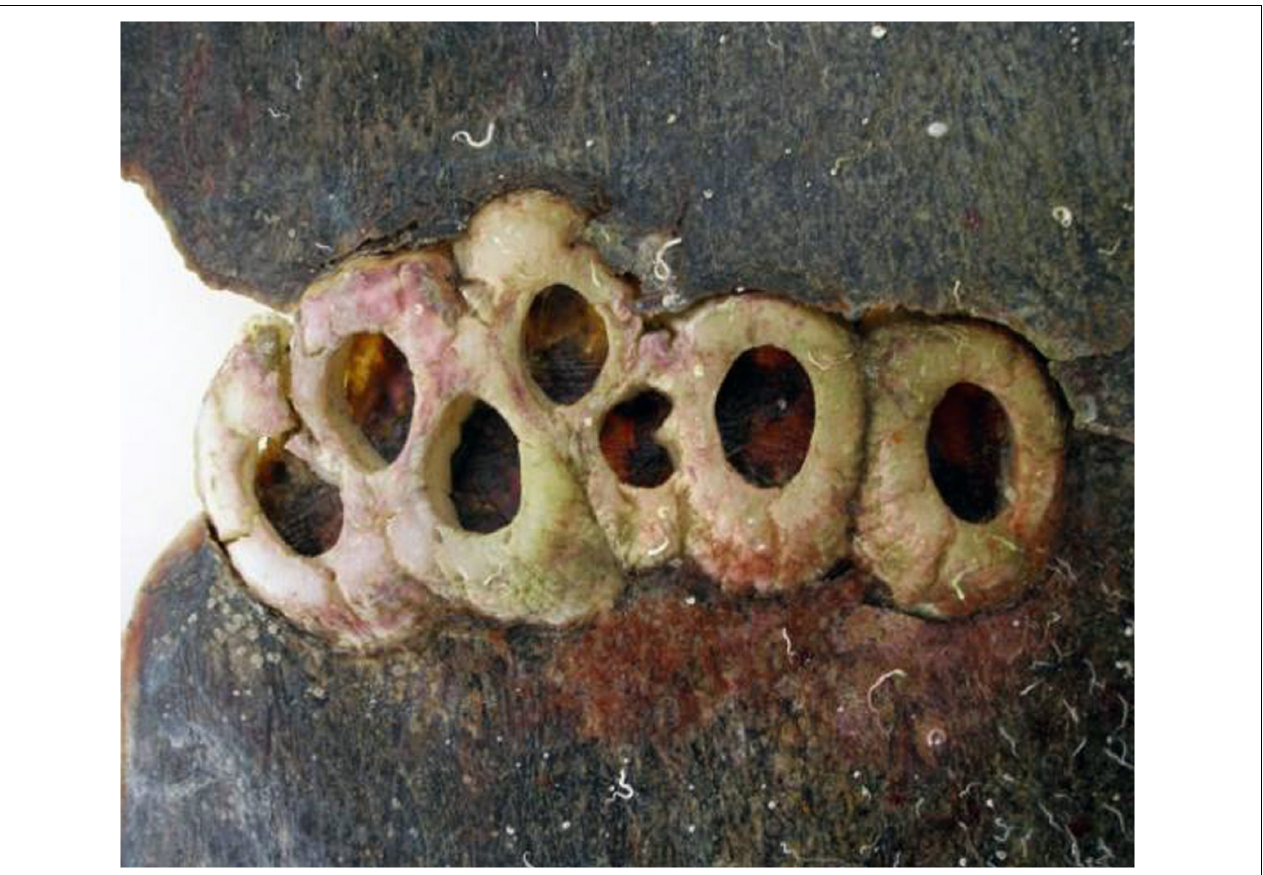
FIGURE 5 | Empty shells of the barnacle Chelonibia caretta entrenched in the thick carapacial scutes of a deceased hawksbill sea turtle, demonstrating the destructive downward cutting action of the barnacle shell margin (photo courtesy of Nicolas